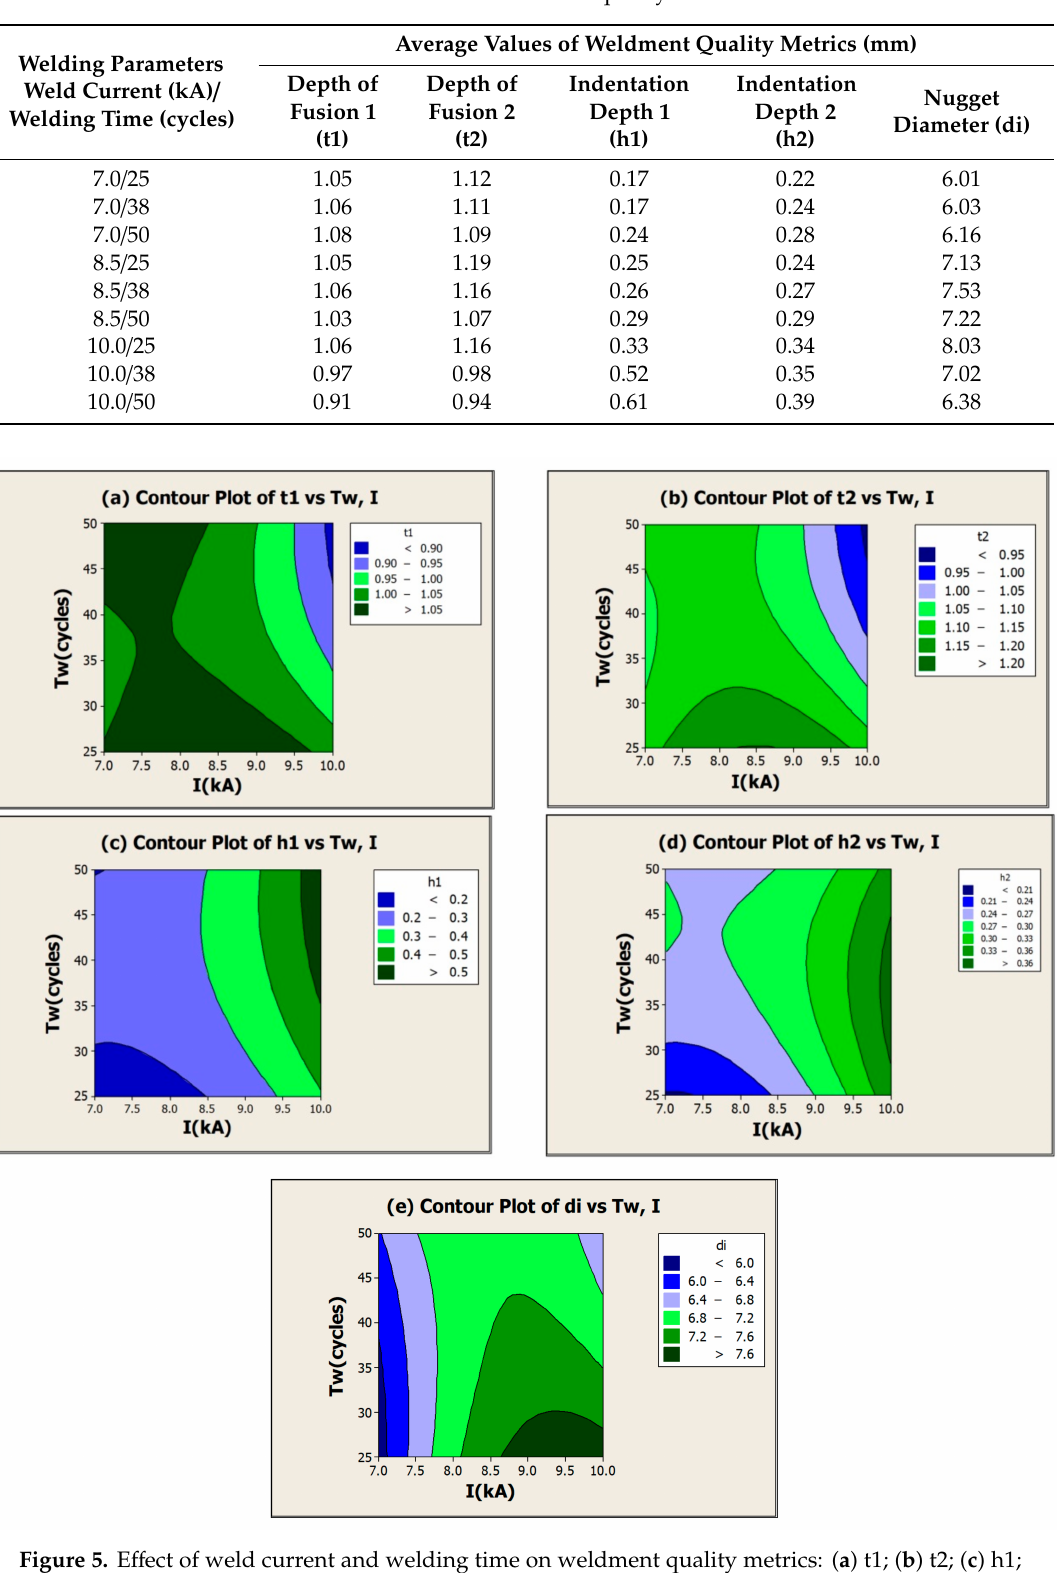
Table 5. Macrostructure of five quality metrics.